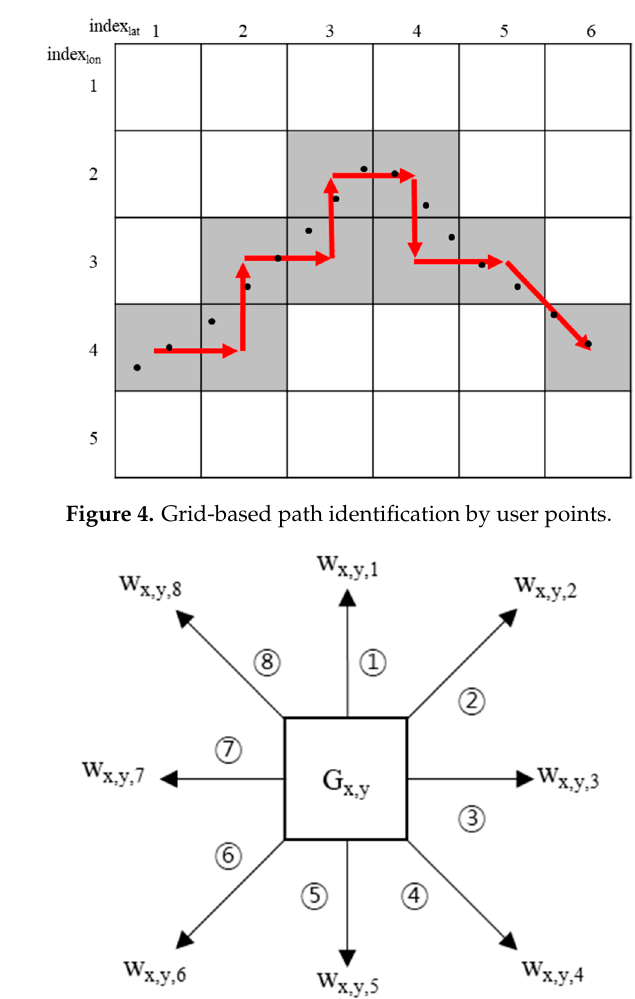
Figure 5. Weights of grid in eight directions.